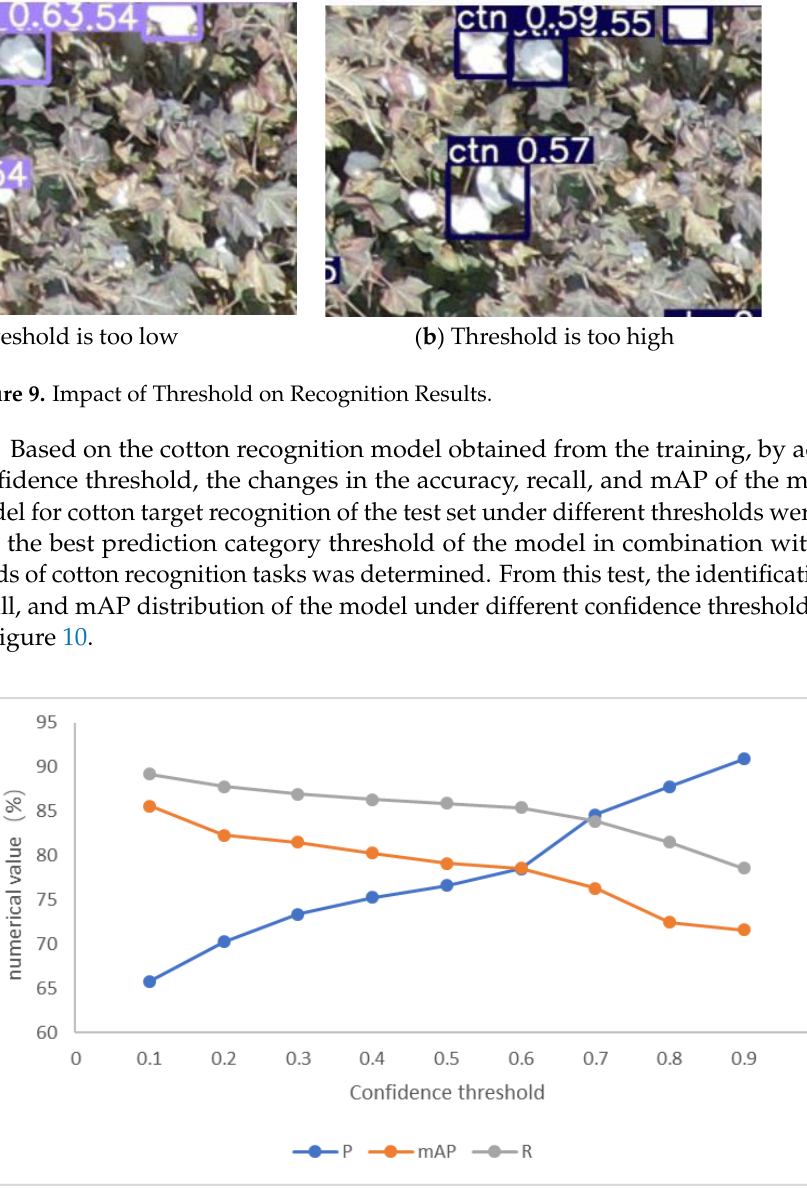
Figure 10. Changes of performance parameters of model with different confidence thresholds.